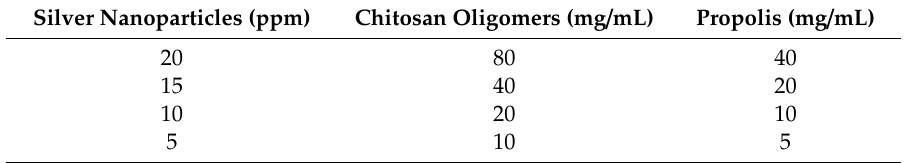
Table 1. Concentrations of the wood preservative substances used in the impregnation treatments. Silver Nanoparticles